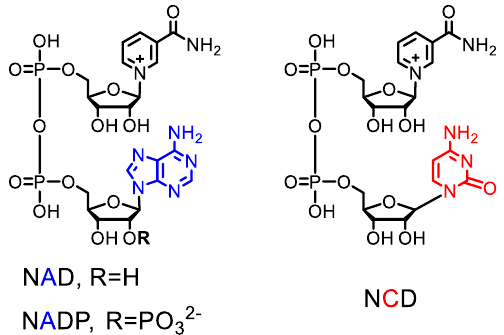
Figure 1. Chemical structures of NAD(P) and NCD.